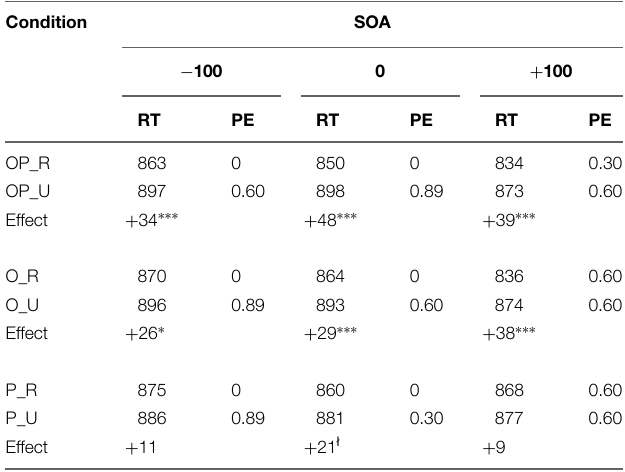
TABLE 4 | Summary of fixed effects in the linear mixed-effects model for onset latencies in Experiment